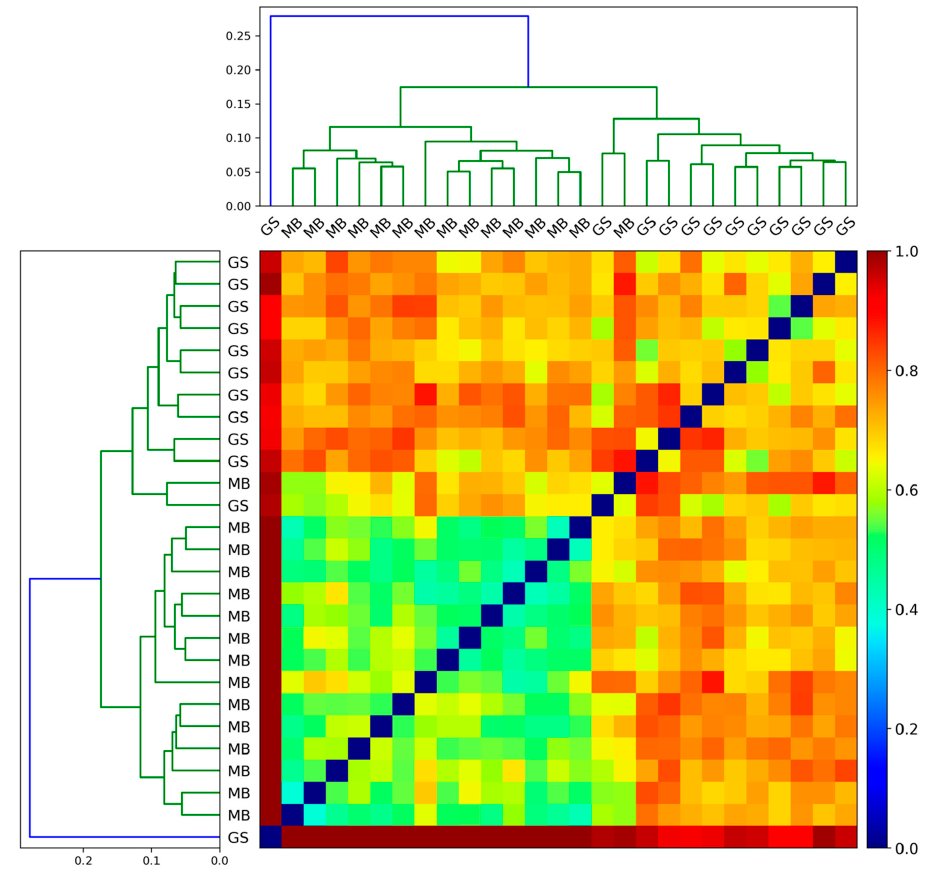
Figure 3. Heat-map diagram of the gut microbiota composition at genus level for two groups. Table 1. Mean relative frequency of abundance (%) and corresponding standard deviation (SD) (%) of the phyla identified in the caeca of mixed breeds (MB) and German Shepherd (GS) dogs. The species indicated are those showing a mean relative frequency of abundance ≥ 0.1% in at least one group. p values in bold are those significantly different.